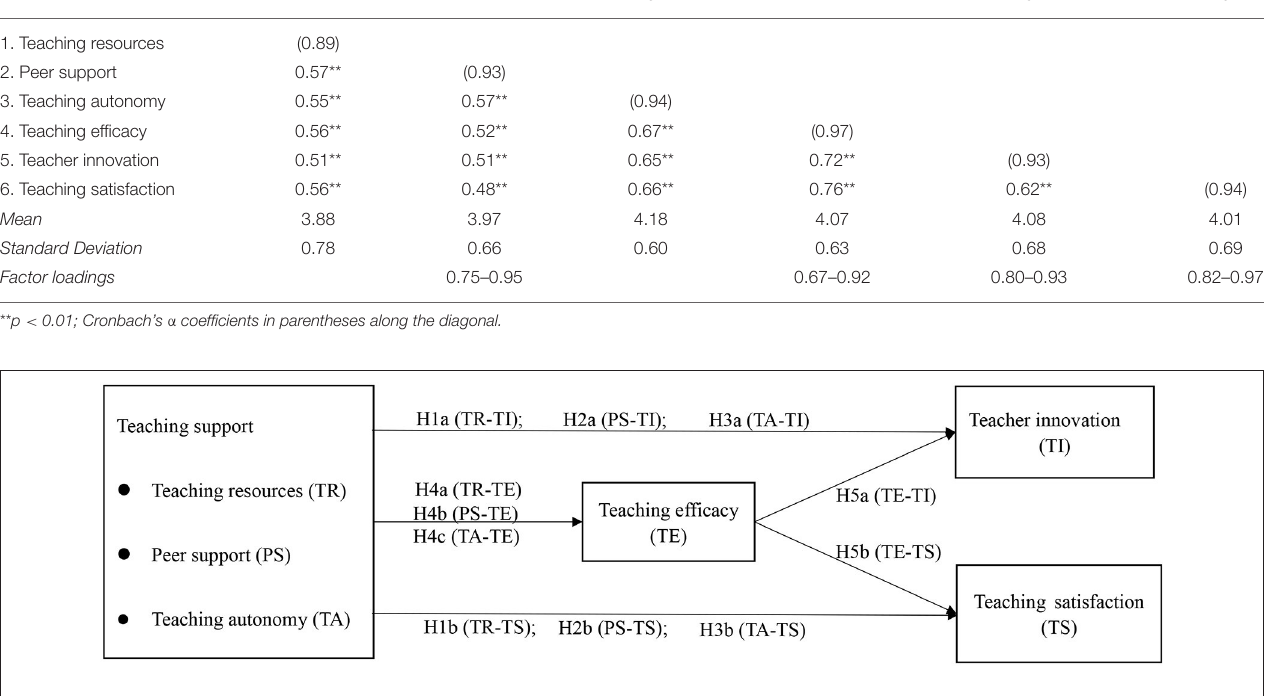
FIGURE 1 | The hypothesised